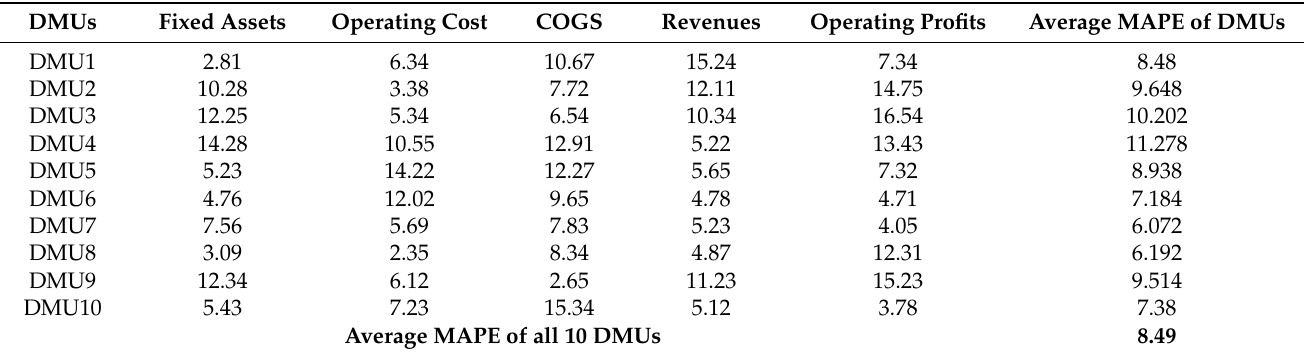
Table 5. Average MAPE of DMUs (in %).